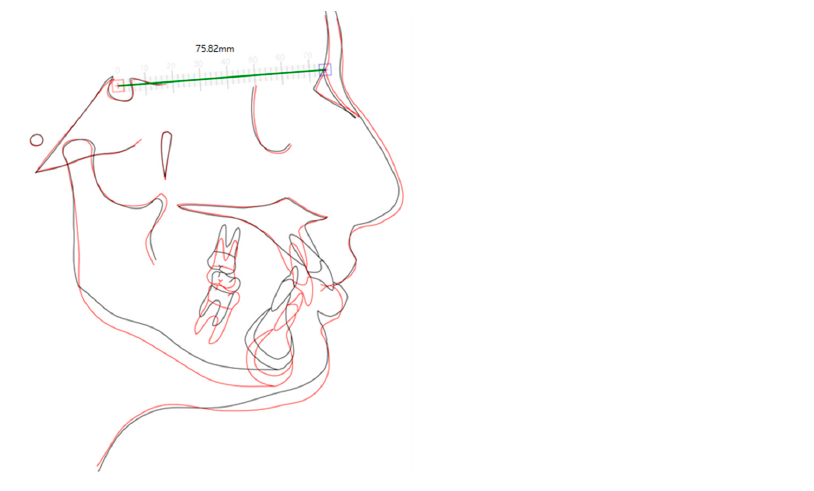
Figure 15. Superimposition of the initial tracing (black) and final tracing